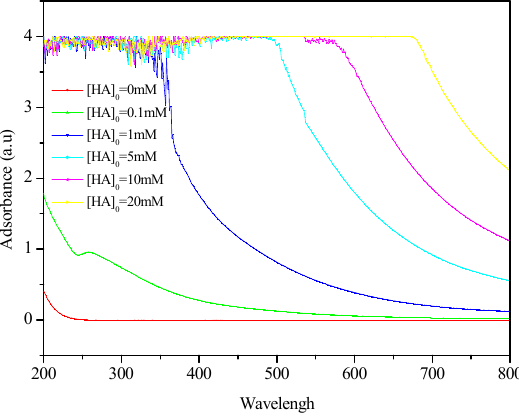
Figure 10. E ff ect of HA on KET ( a ) and METH ( b ) degradation in the UV / H 2 O 2 system. Conditions: Figure 10. Effect of HA on KET (a) and METH (b) degradation in the UV/H 2 O 2 system. Conditions: (KET) 0 = (METH) 0 = 100 μg/L, (H 2 O 2 ) 0 = 500 μM, pH 0 = 7.0, T = 25 ± 1 °C.